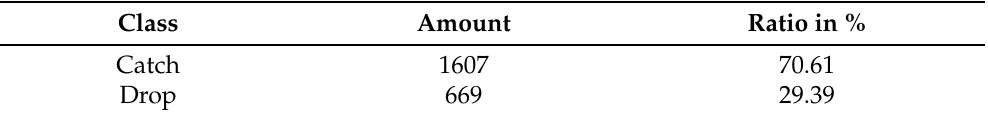
Table 1. Catch Attempts per